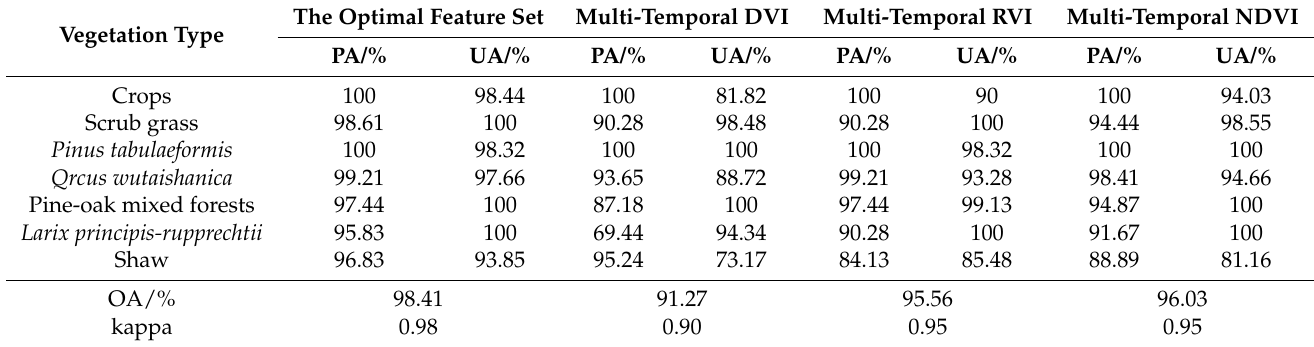
Table 5. Classification accuracy of feature set for different vegetation indices.